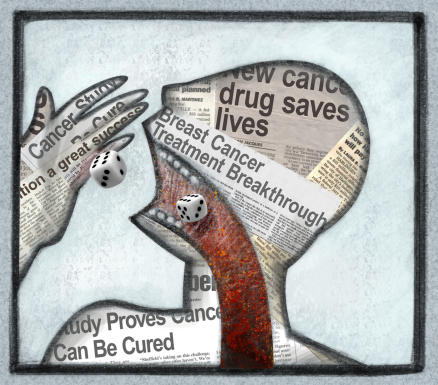
The rush to embrace unproven treatments can end up harming patients(Illustration: Giovanni Maki)